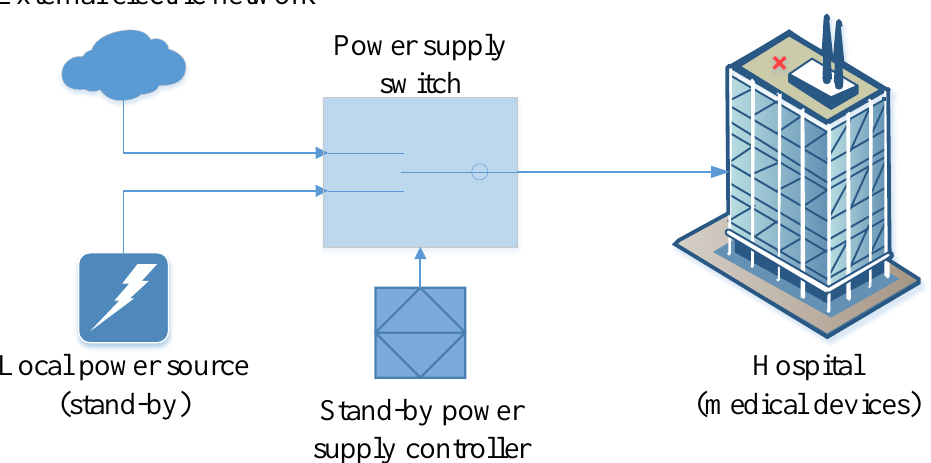
Figure 1. Block diagram of the power supply system of medical equipment in a